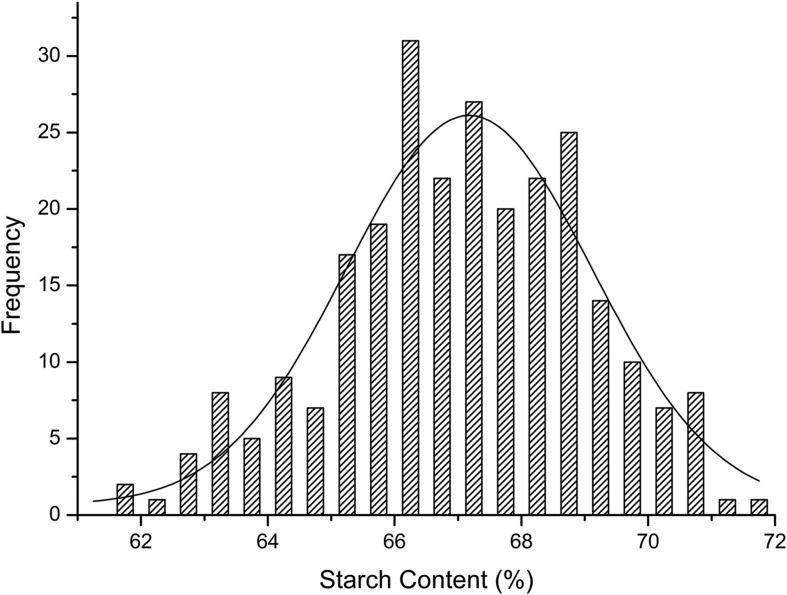
Frequency map of starch content.